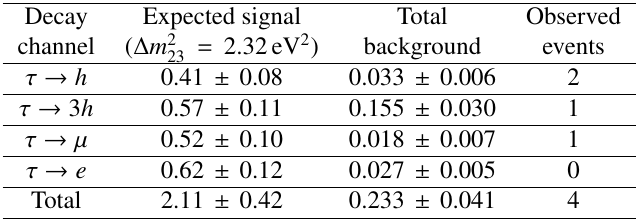
Table 4. Estimated signal and background events for the analysed sample. Numbers are reported separately for each of the four τ decay channels. Observed events in each channel are also